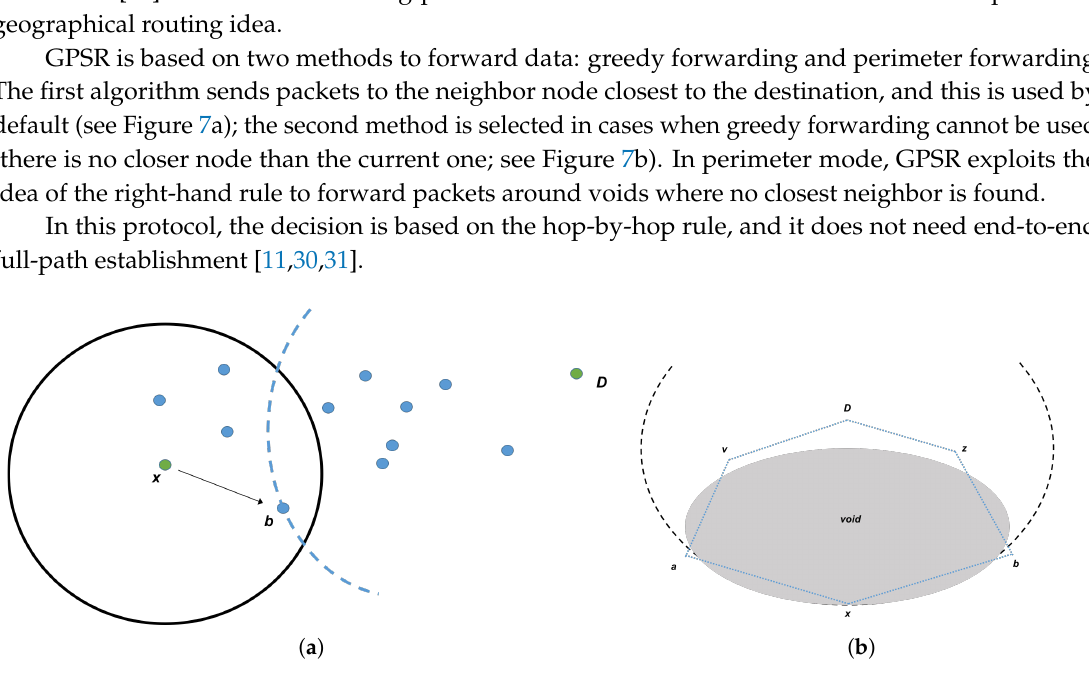
Figure 7. Greedy perimeter stateless routing (GPSR) operation. ( a ) greedy-forwarding example. b is the x ’s closest neighbor to D . ( b ) In perimeter mode, node x is void with respect to destination D